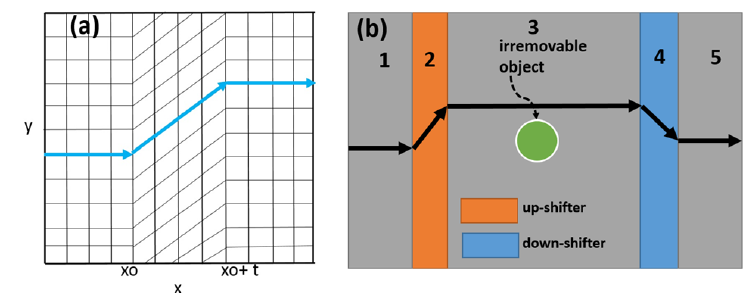
Figure 2. A linear coordinate transformation of a beam shifter and its application ( a ) appropri- ate coordinate transformation for up-shifting. ( b ) a set of beam shifters for both up-shifting and